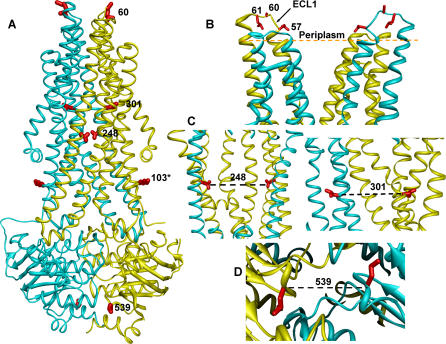
Sites of Spin Labeling in the Sav1866 Structure
(A) Ribbon representation of Sav1866 structure highlighting sites of spin labeling using the numbering scheme of MsbA. (B) Locations of labeling sites 57, 60, and 61 in the ECL1 loop on the periplasmic side of Sav1866. (C) Relative orientations of sites 248 and 301 in a close up view through the closed chamber at the cytoplasmic side. The front helices are deleted to open the view of the two residues. (D) Top view of the NBDs in Sav1866 highlighting the location of 539.